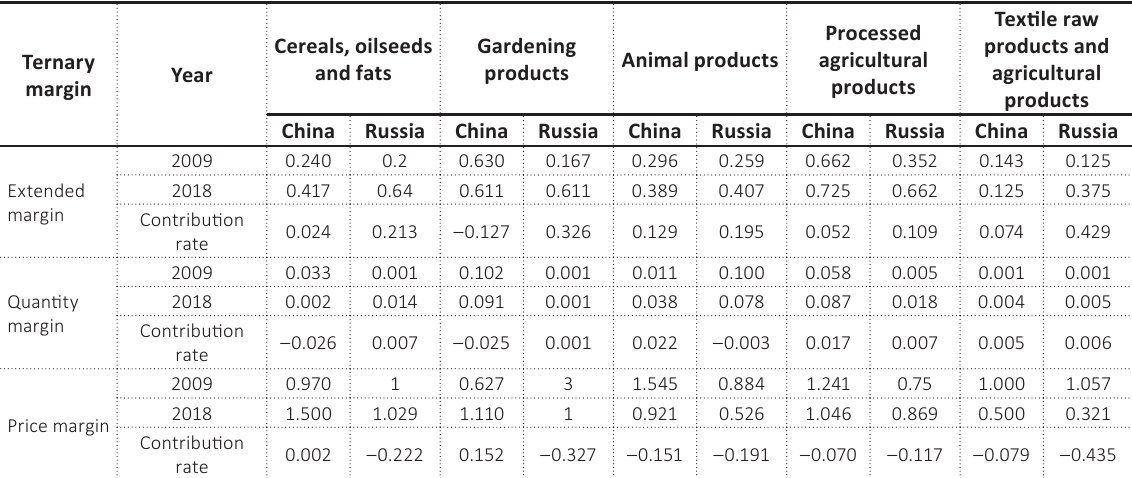
Table 2. The ternary margin and contribution rate of different types of agricultural exports of China and